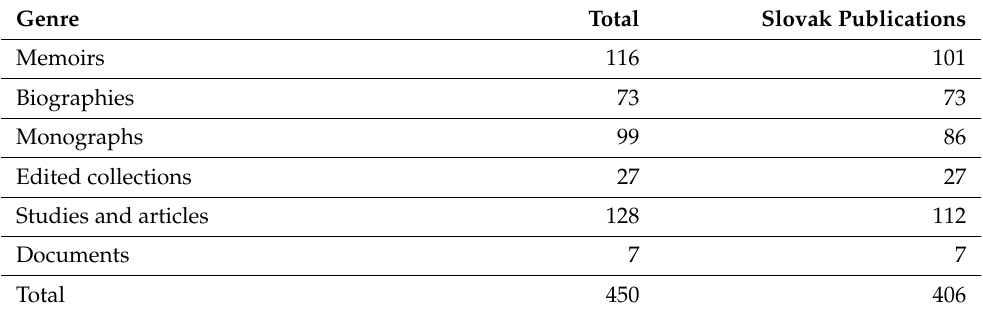
Table 1. Number of